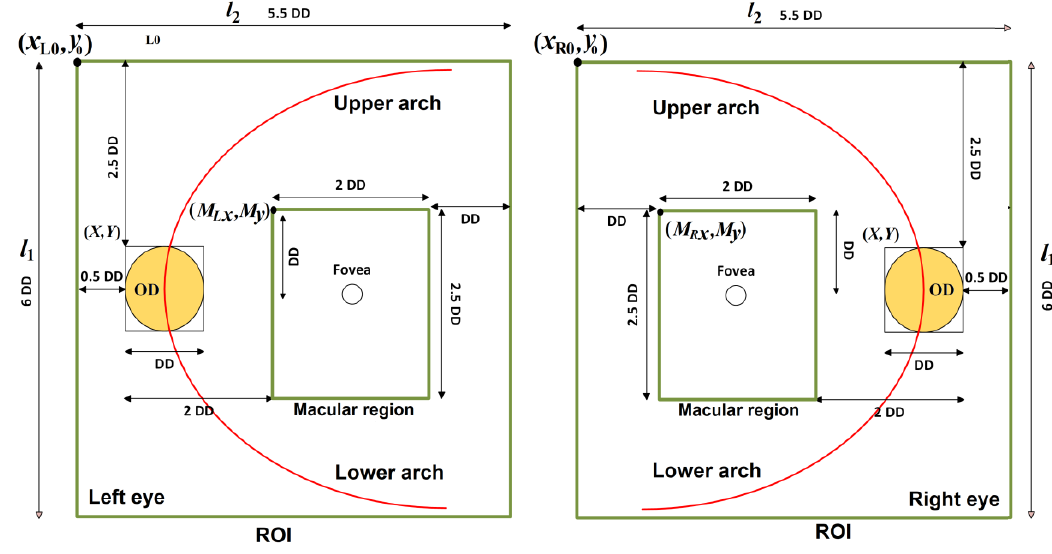
Figure 7. ROI and macular region of the left and right eyes.